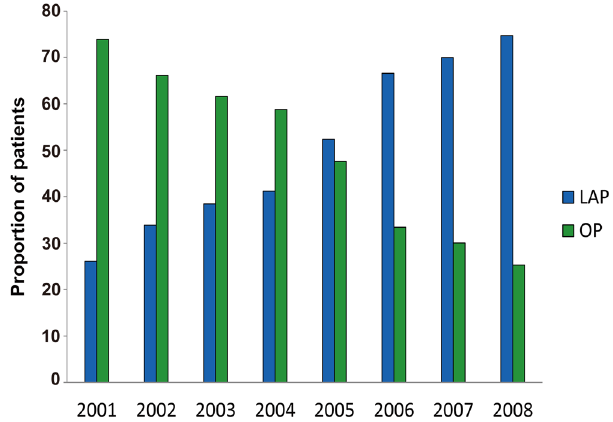
Figure 1. Rates of LAP and OP over time in patients with pathological stage T 1 N 0 M 0 gastric cancer from the participating